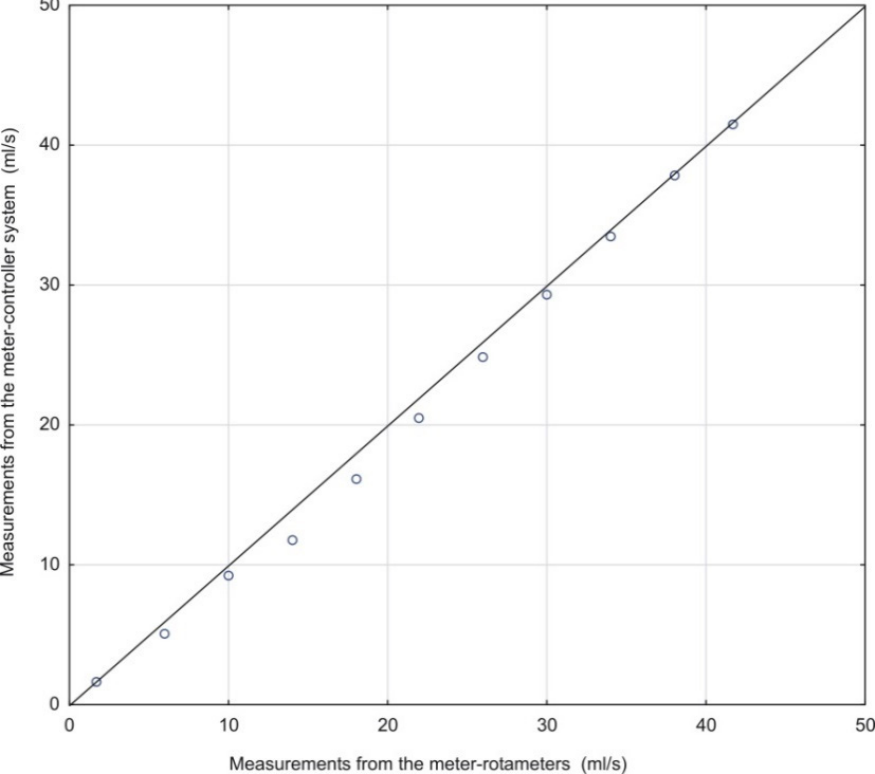
Figure 7. Correlation diagram of measurements from the meter-controller system vs. reading from rotameters.